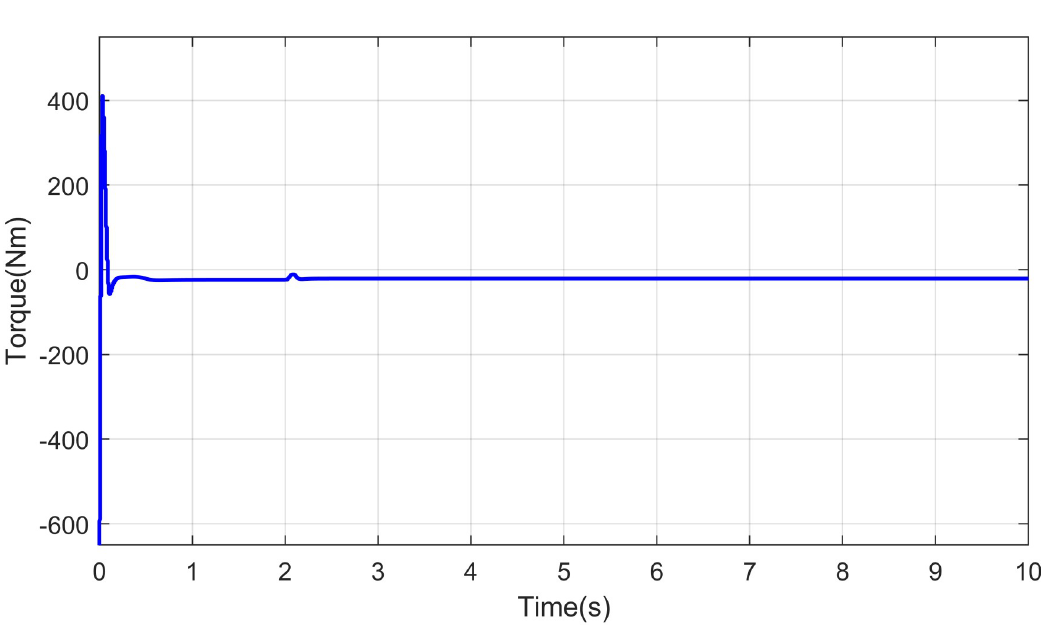
Fig 14. Control effort of waist joint of a robot manipulator.